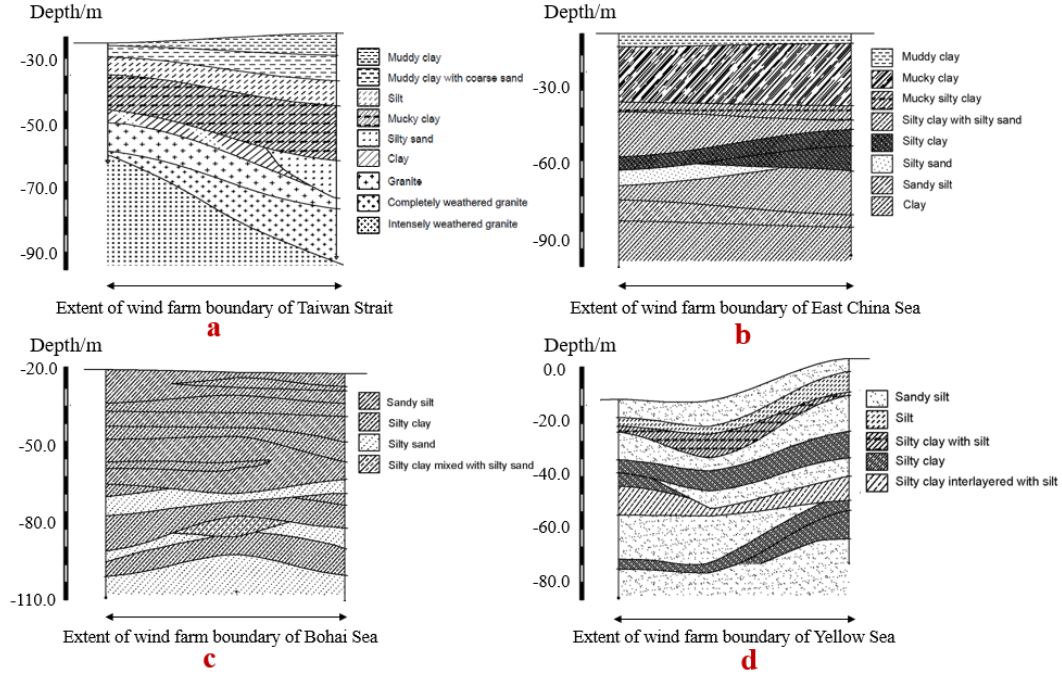
Figure 2. Typical ground profiles in Chinese waters: ( a ) Taiwan Strait; ( b ) East China Sea; ( c ) Bohai Sea; ( d ) Yellow Sea (modified from [48]).